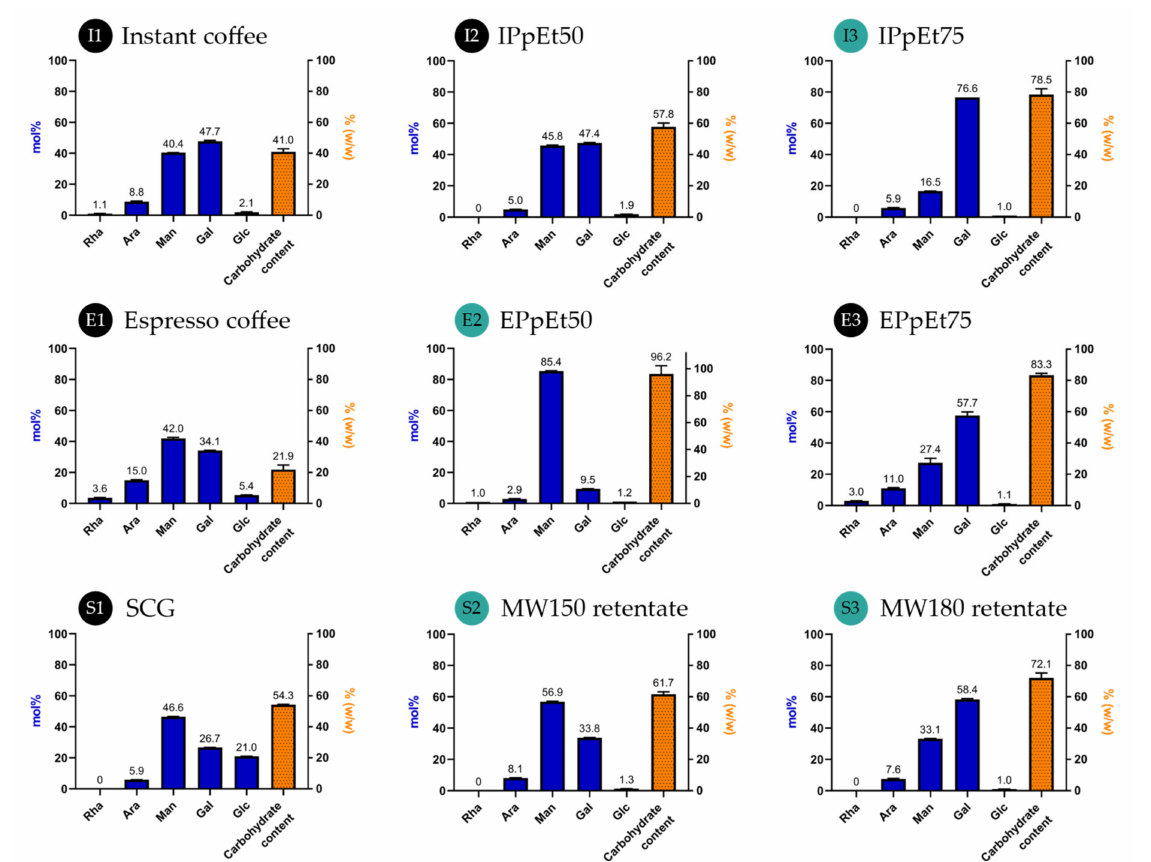
Figure 2. Carbohydrate content and composition of chosen fractions. E1, E2, and E3 correspond to fractions from espresso coffee; I1, I2, and I3 correspond to fractions from instant coffee, and S1, S2, and S3 correspond to fractions from SCG. Codes names are referenced in Figure